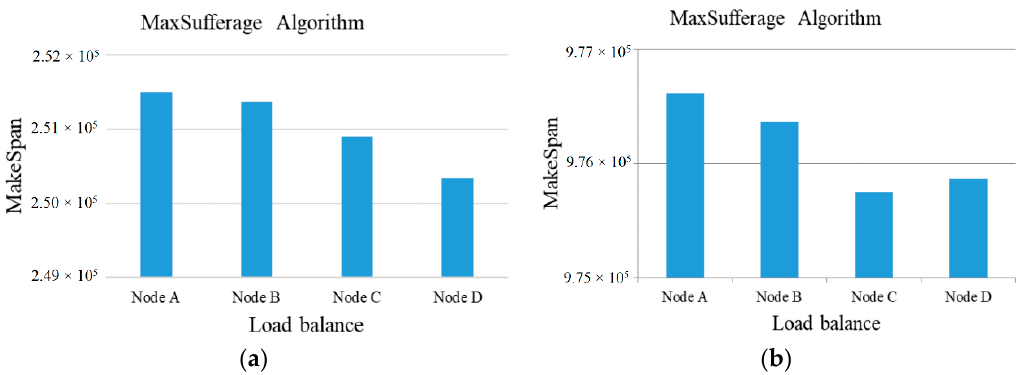
Figure 4. The results of load balancing index in the MaxSufferage scheduling algorithm for ( a ) n = 4 and number of tasks = 50 and ( b ) n = 4 and number of tasks = 100.